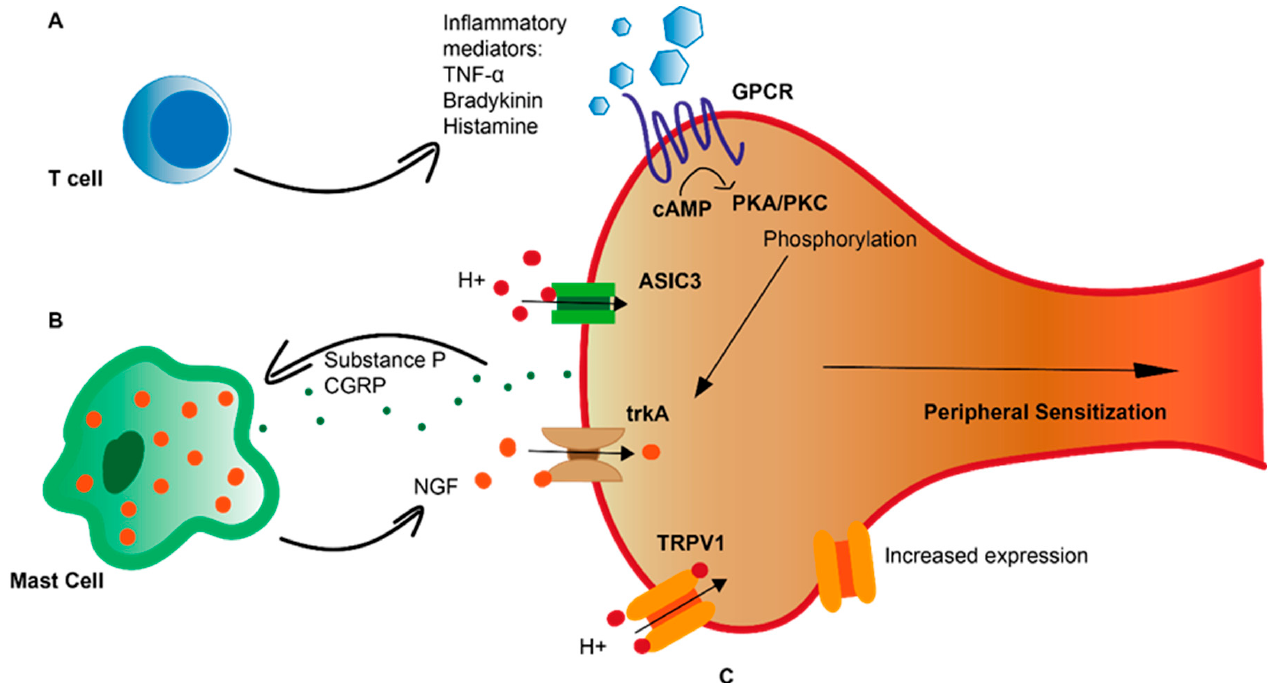
Figure 1. Mechanisms of peripheral sensitization illustration of increased action potential firing in response to a variety of noxious stimuli. ( A ) Mechanisms of nociceptor activation include GPCR activation releasing cAMP and activating protein kinases which phosphorylate ion channels, thus reducing their transduction threshold. ( B ) Upregulation of ion channels such as TRPV1, thereby increasing response to noxious stimuli such as acid. ( C ) Bidirectional neuroimmune crosstalk, including SP and CGRP release from the nerve terminal activating mast cells to release NGF, and NGF activating its receptor trkA expressed on nerve endings. TNF- α : tumor necrosis factor- α ; GPCR: G-protein-coupled receptor; cAMP: cyclic adenosine monophosphate; PKA/PKC: protein kinase A/C; ASIC3: acid-sensing ion channel-3; trkA: tropomyosin receptor kinase; TRPV1: transient receptor potential vanilloid-1; CGRP: calcitonin gene-related peptide; NGF: nerve growth factor. Acid-sensing ion channels (ASICs) are sensors of extracellular pH which belong to a voltage-insensitive, amiloride-sensitive family of cation channels that are solely activated by extracellular protons, making them a prime candidate for sensation in heartburn pa- tients [22]. Much like TRPV1, activation of ASICs leads to an influx of Na + , which in turn desensitizes the neuron and initiates an action potential, feeding into nociceptive pathways in the central nervous system. Recent findings of ASIC expression on visceral sensory neurons highlight ASICs as likely sensors of acid-induced pain [23]. One such study in mouse skin found ameliorated sensitivity to noxious pinch and acid infusion in ASIC3 knockout mice compared to wild type [24]. Importantly, while there is extensive evidence to demonstrate expression of ASICs predominantly on peripheral nerve fibers of extrinsic primary afferent neurons from the dorsal root and nodose ganglia, emerging evidence suggests ASIC1–3 expression on other cells including oesophageal epithelial cells [25–27]. A study of an in vivo rat model perfused the distal oesophagus with acid solutions through a mucosal perfusion chamber in the presence and absence of ASIC inhibitors [26]. The investigators reported hyperaemia in the presence of CO 2 challenge, while the administra- tion of generic ASIC inhibitor amiloride was found to inhibit the CO 2 response, suggesting that luminal perfusion of CO 2 can diffuse into the oesophageal mucosa, and activate the acid sensors to result in hyperaemia